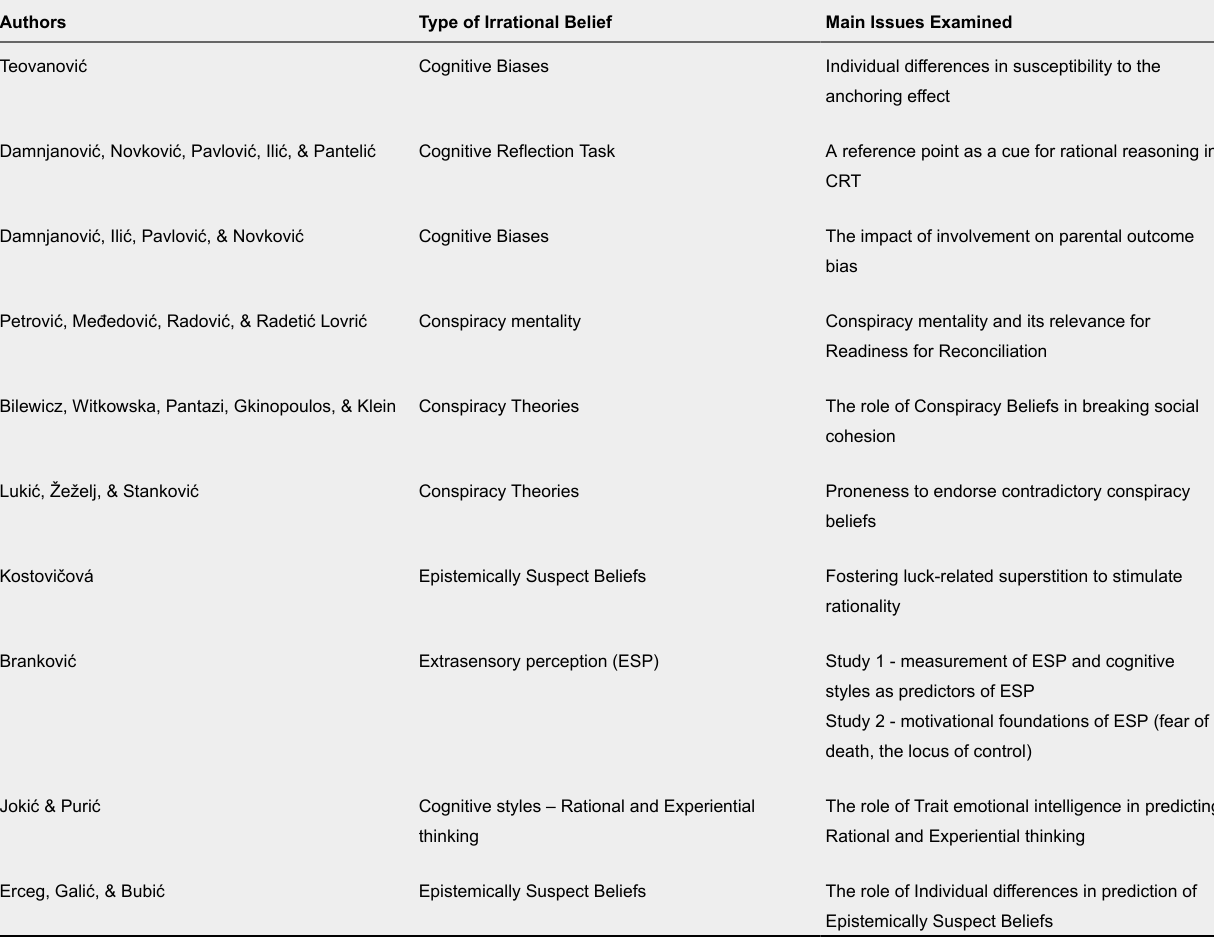
Overview of Research Studies in the Special Issue Irrational